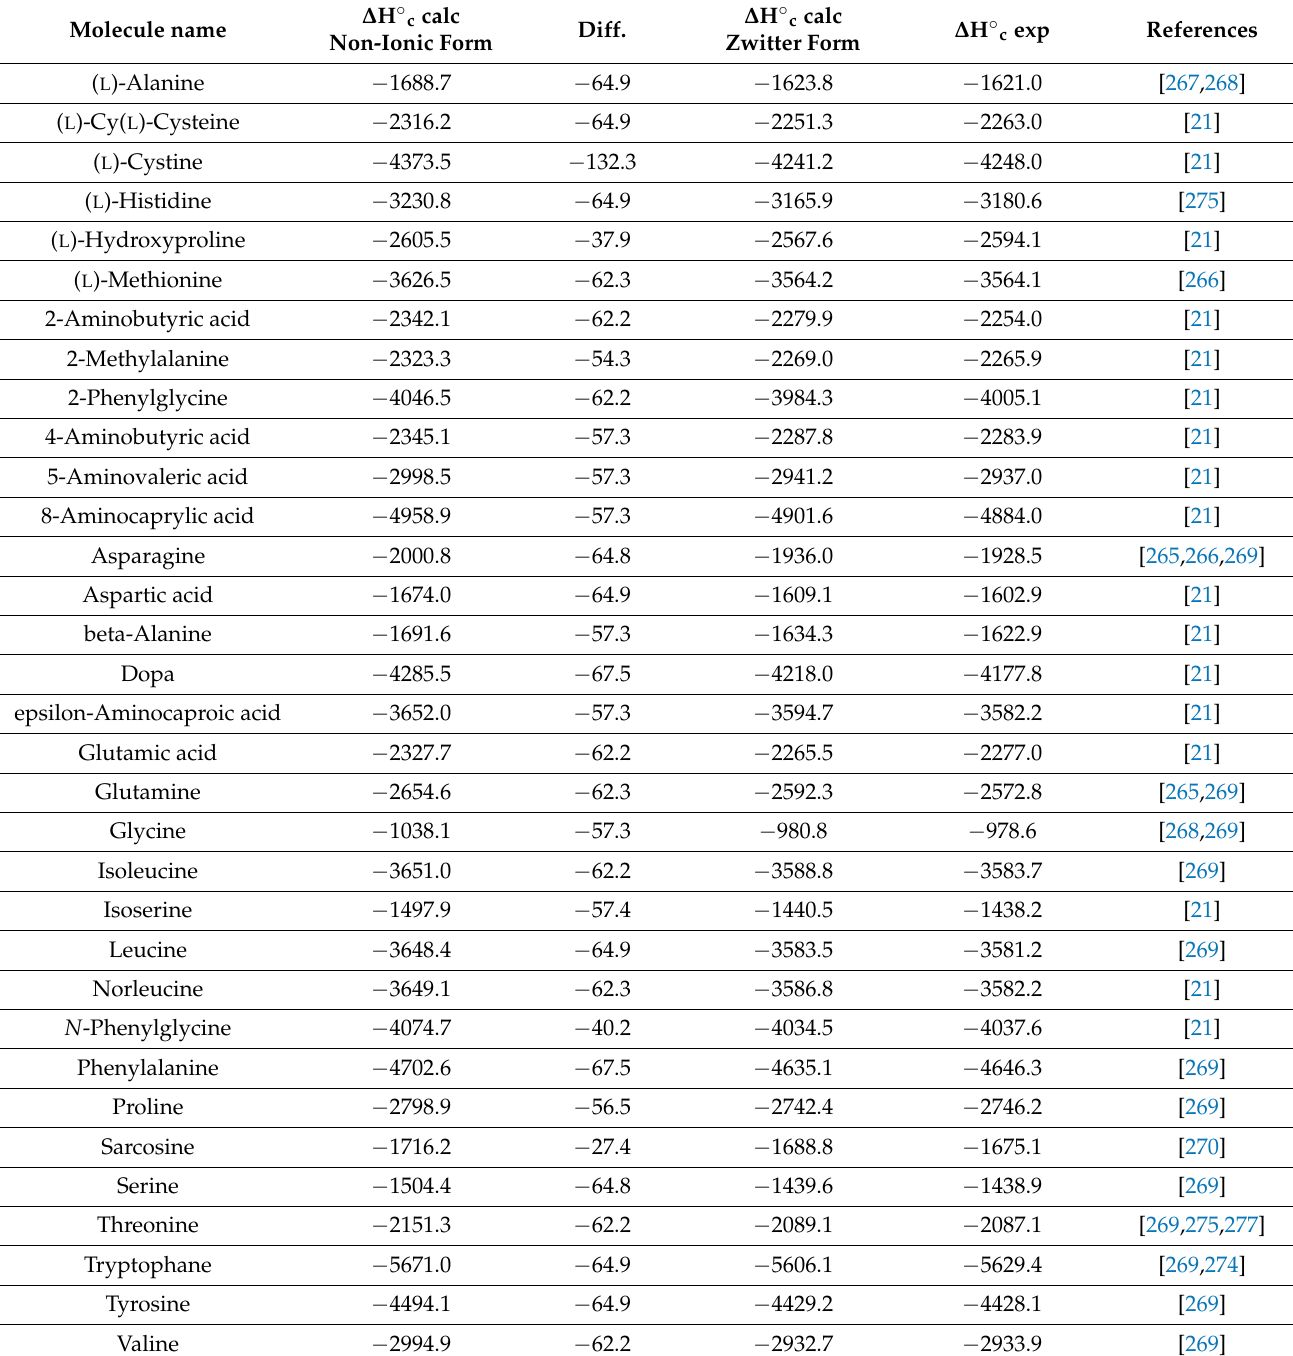
Table 5. Calculated ∆ H ◦ (c) (in kJ/mol) of Non-ionic and Zwitter-ionic Forms of Amino